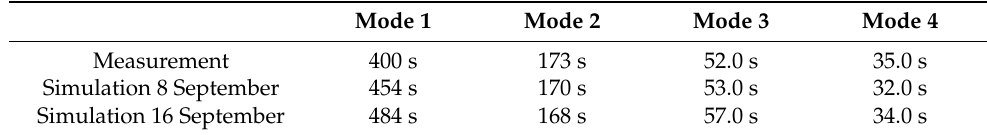
Table 6. Natural periods from measurement and numerical